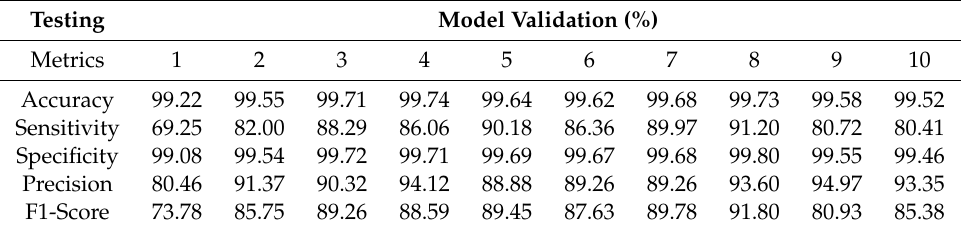
Table 5. Testing performances based on 10